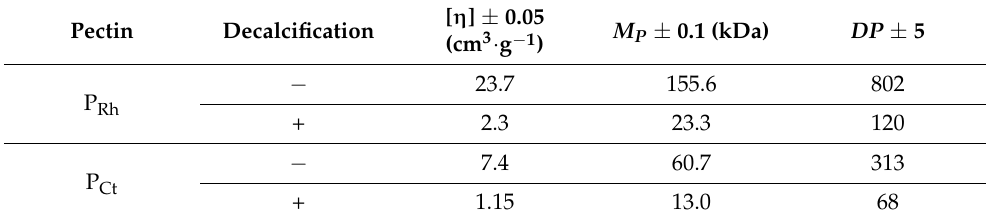
Table 5. Results of the viscosimetric assessment of the molecular weight of pectin preparations. [ η ] ± 0.05 Pectin Decalcification Pectin